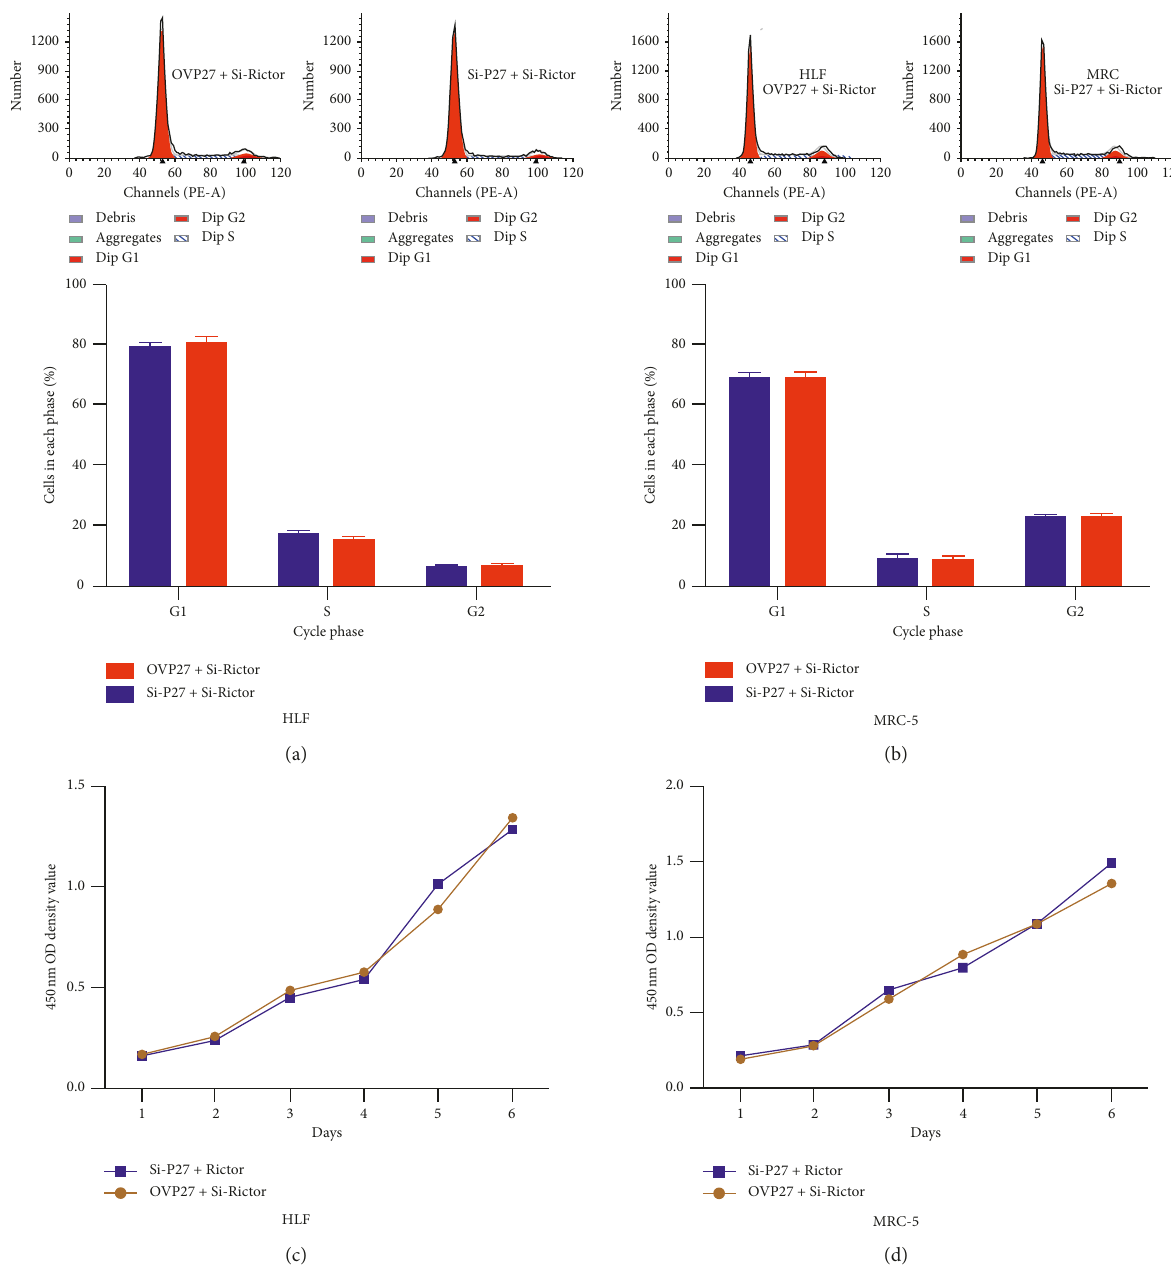
Figure 5: Rictor knockdown reversed the role of P27 on cell cycle and proliferation. (a, b) The cell cycle assay in MRC5 and HLF cells transfected with P27 siRNA plus Rictor siRNA or P27 ovexpression vector plus Rictor siRNA. (c, d) The cell proliferation assay in MRC5 and HLF cells transfected with P27 siRNA plus Rictor siRNA or P27 ovexpression vector plus Rictor